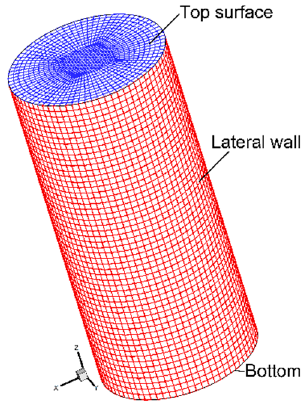
Figure 4. Boundaries of the computational domain and the mesh used in the simulation.